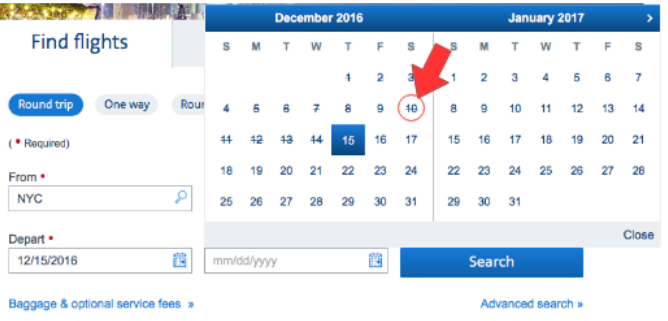
Figure 18. An attempt to select a return date before the departure